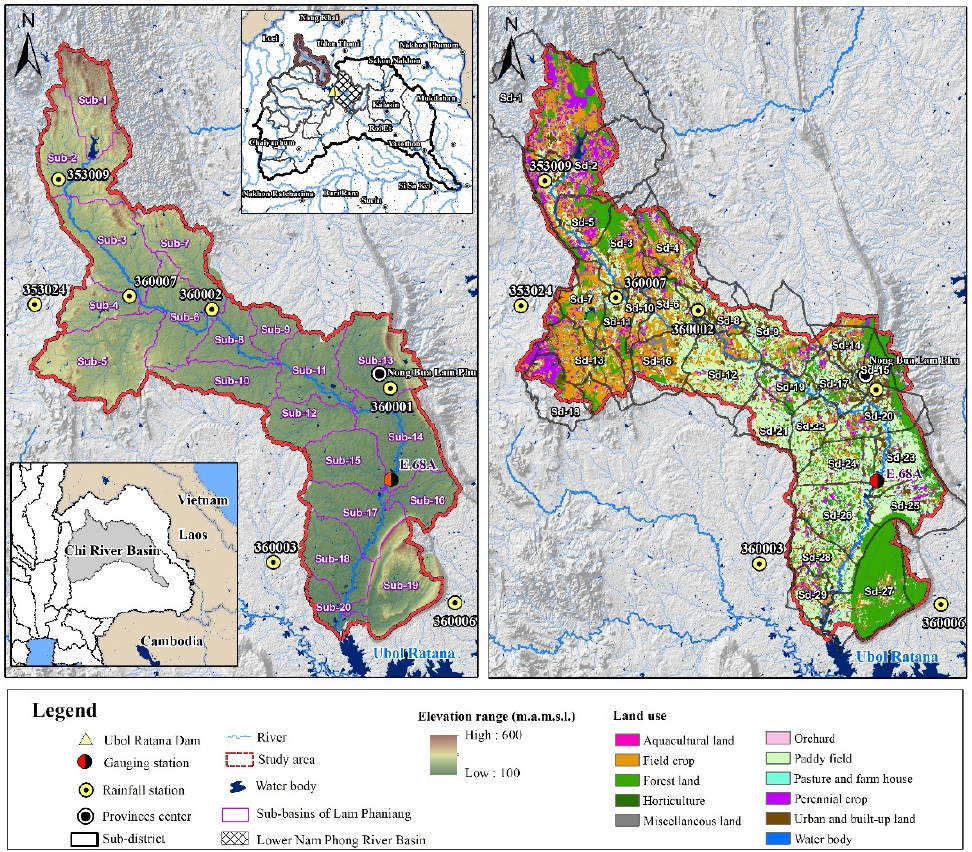
Figure 1. Location of the study area, and its topography and land use.